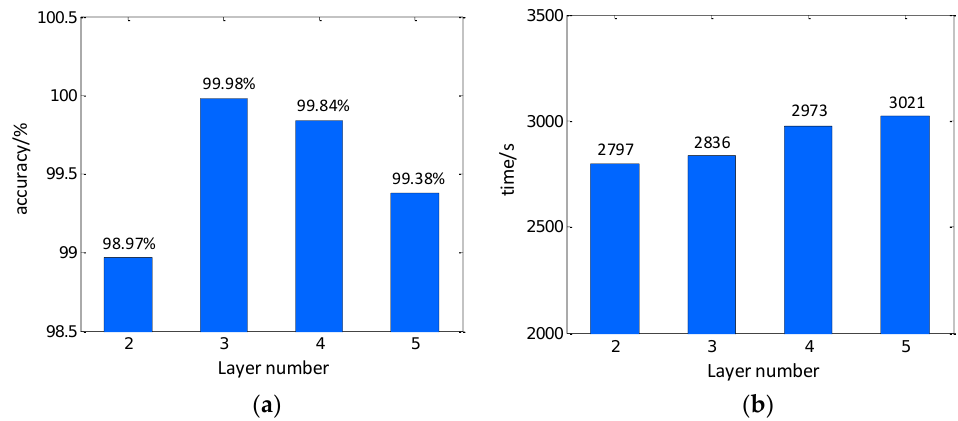
Figure 11. Training results under different number of convolutional layers. ( a ) Accuracy, ( b ) Time. Table 6. The influence of main hyperparameter settings on model recognition accuracy.